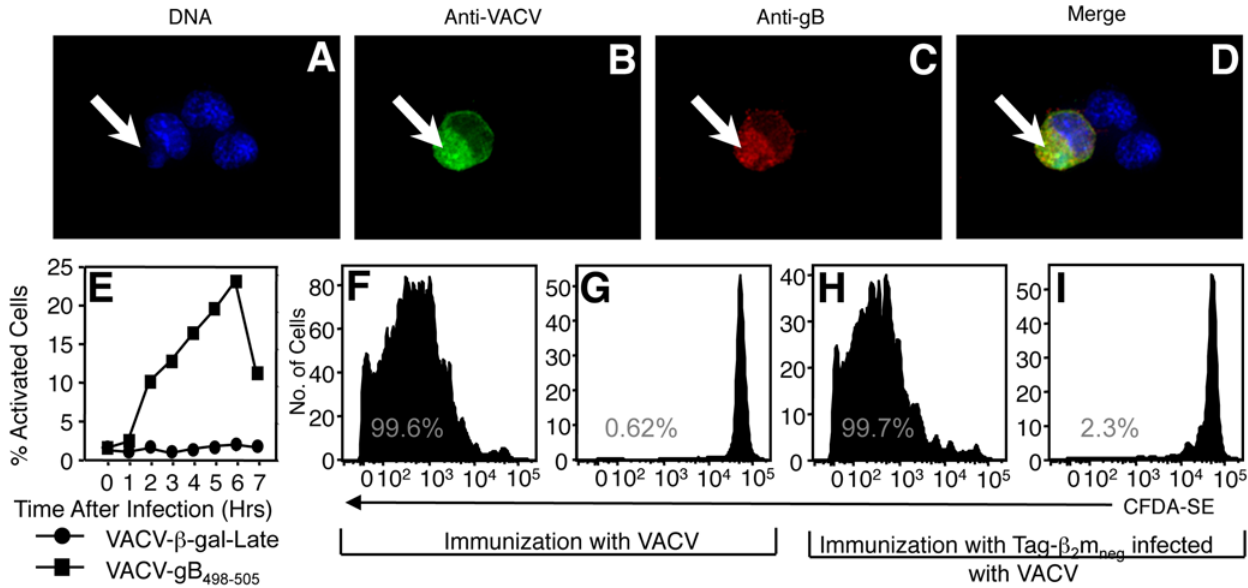
Figure 7. Late VACV promoter-driven antigen that exits virus factories is not directly presented, but is available for cross priming. TAg- b 2 m neg cells were infected with rVACV-gB-Late (A–D) for 5 h, fixed and stained with a polyclonal antisera to VACV (B,D) and a monoclonal antibody to HSV gB (C,D) and the nuclear counterstain DAPI (A,D). The white arrows indicate the location of viral factories in infected cells. (E) Direct presentation to a gB 498–505 specific T CD8 + line was measured following infection of BMDC with rVACV-gB-Late ( $ ) or rVACV-gB 498–505 ( & ). (F–I) Proliferation of adoptively transferred gB 498–505 -specific TCR transgenic T CD8 + was measured following immunization with rVACV-gB-Late (F), VACV that did not express gB (G), TAg- b 2 m neg cells infected with rVACV-gB-Late (H) or TAg- b 2 m neg cells infected with VACV that did not express gB (I).